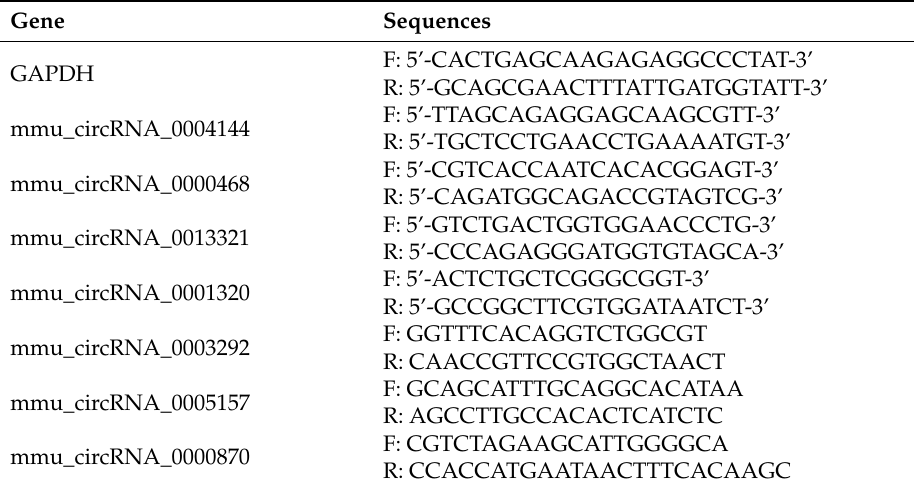
Table 1. The primers used in this